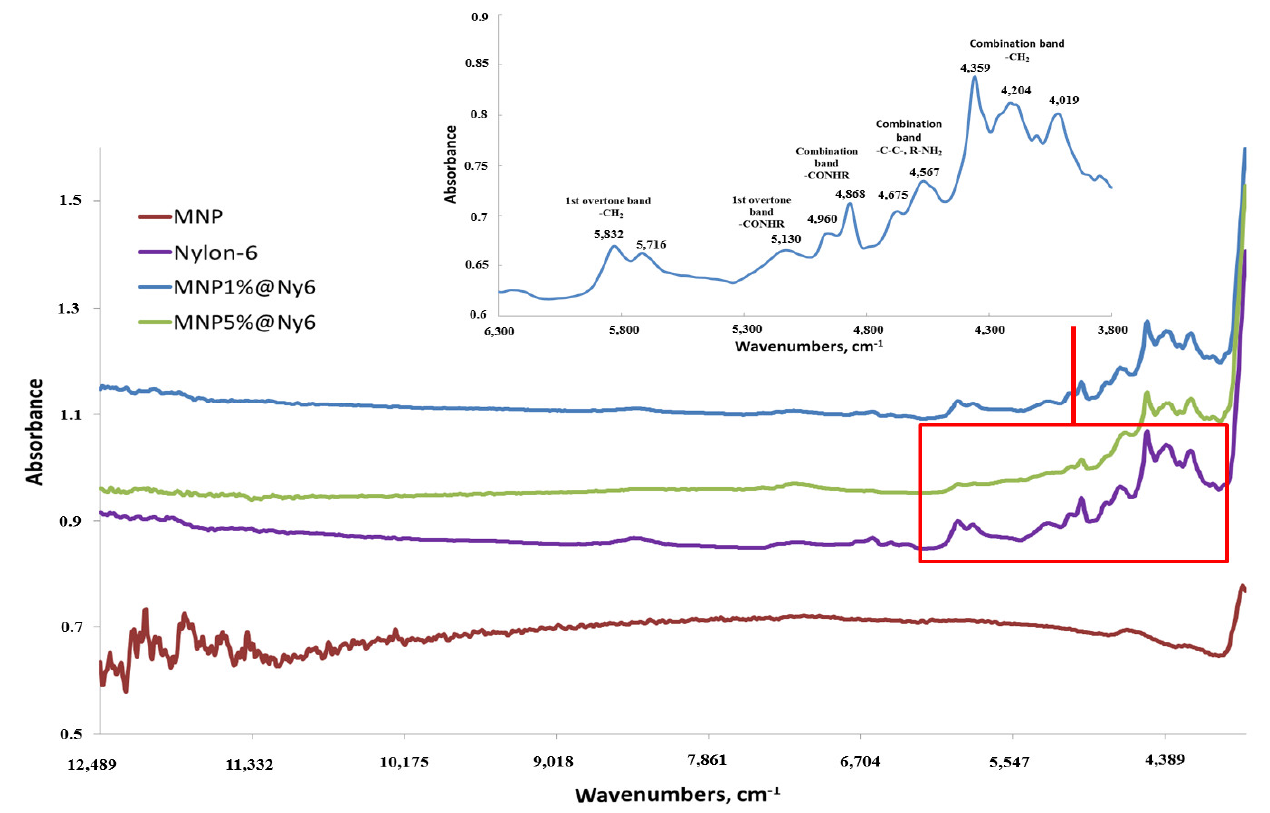
Figure 3. Fourier transform near-infrared spectra of MNP, Ny6, MNP1%@Ny6, and MNP5%@Ny6. The spectra were carried out using MPA NIR-spectrometer (Bruker, Billerica, MA, USA) in the range 4000–12,500 cm −1 . The reflection spectra of samples pre-dried from suspension in acetone were recorded as a thin layer on a glass slide (Corning, USA, size 75 × 25 mm, thickness 0.96–1.06 mm) using the Sphere Macrosample mode.